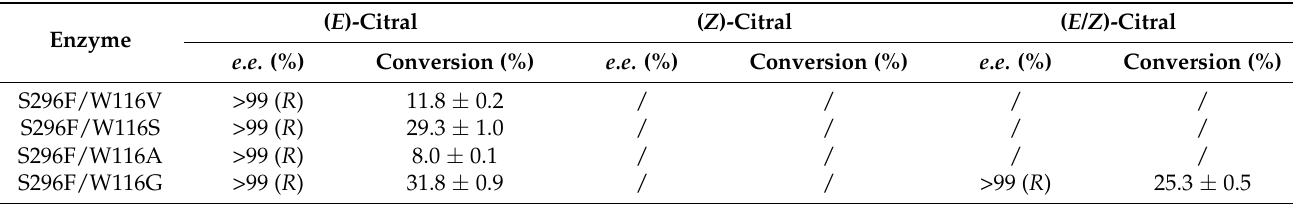
Table 3. The catalytic performances of the S296F/W116X variants of OYE3 1